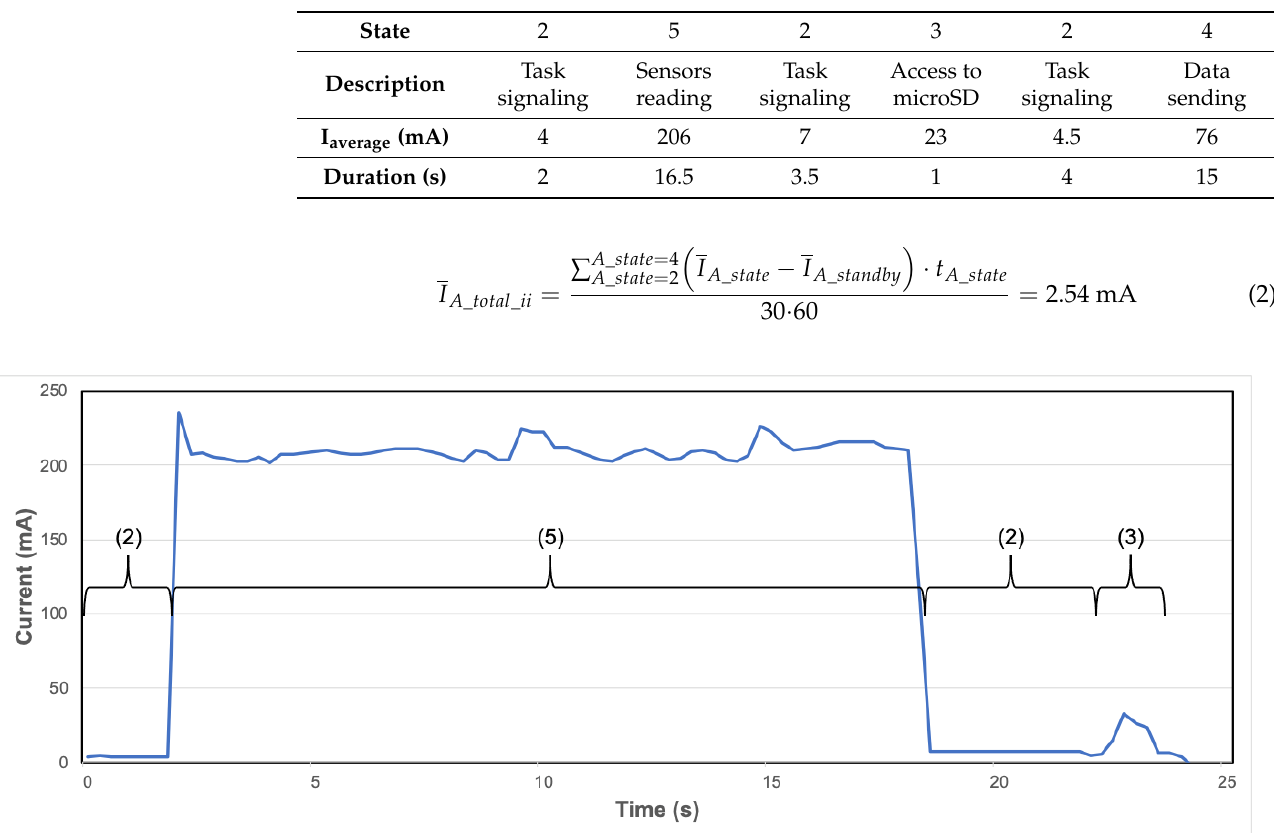
Figure 7. Node A—mode (iii): Sensor reading without data sending (every 30 min).